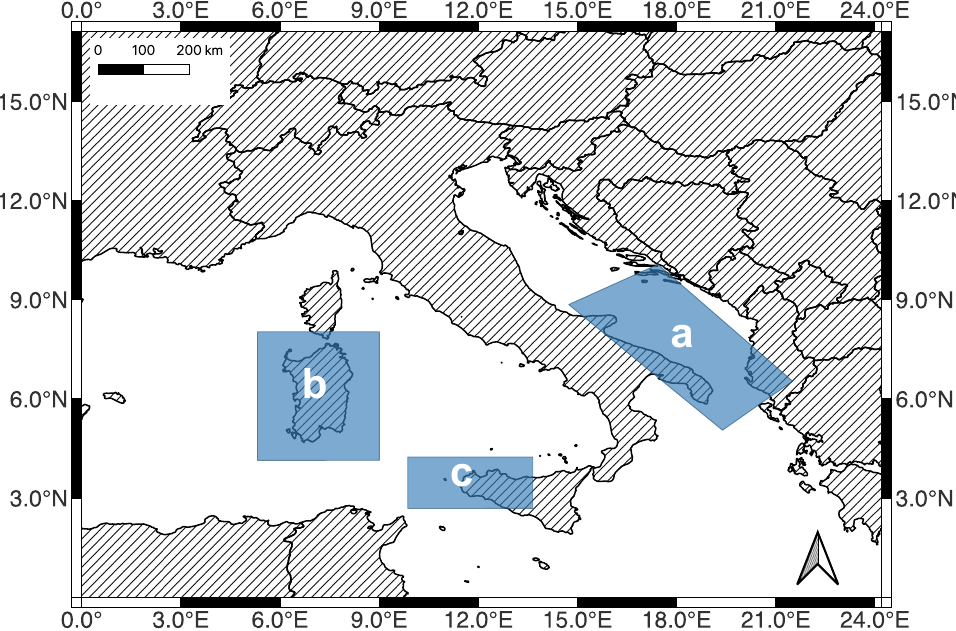
Figure 2. Selected scenarios of interest for the realization of the MM/MF dataset: (a) Adriatic Sea, (b) Sardinia, and (c) the Egadi